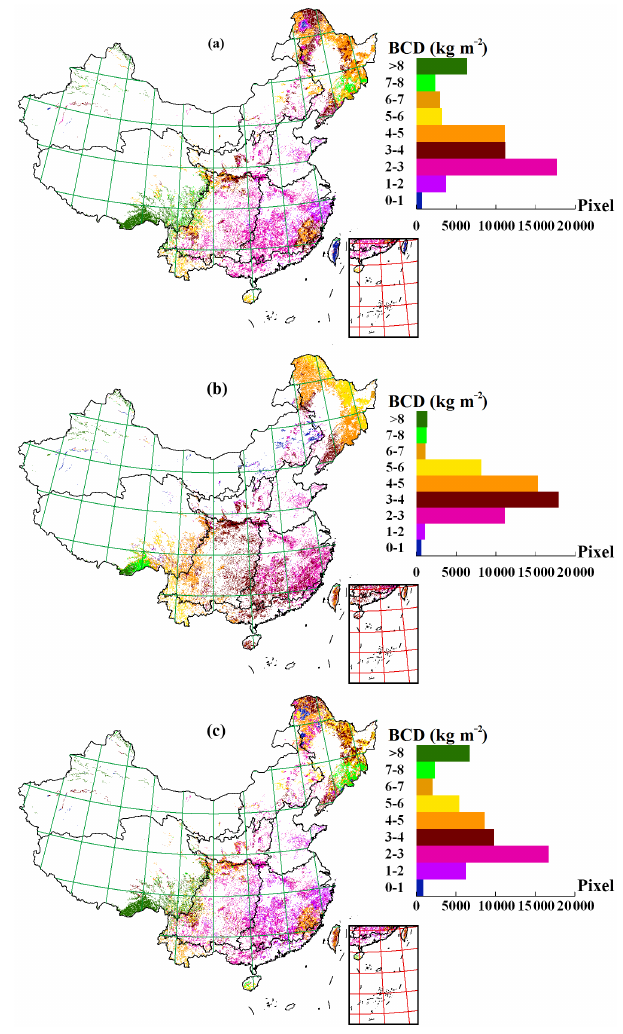
Figure 3. The spatial distribution of forest biomass BCDs estimated during the period 2004–2008 in China using (a) Kriging, (b) SOA, and (c)